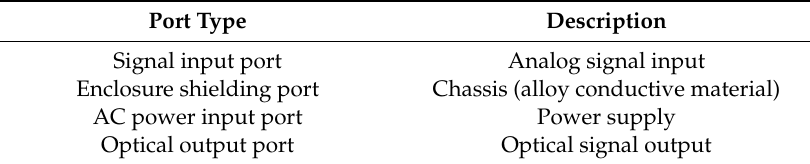
Table 2. The port definition and functions of the ECT acquisition